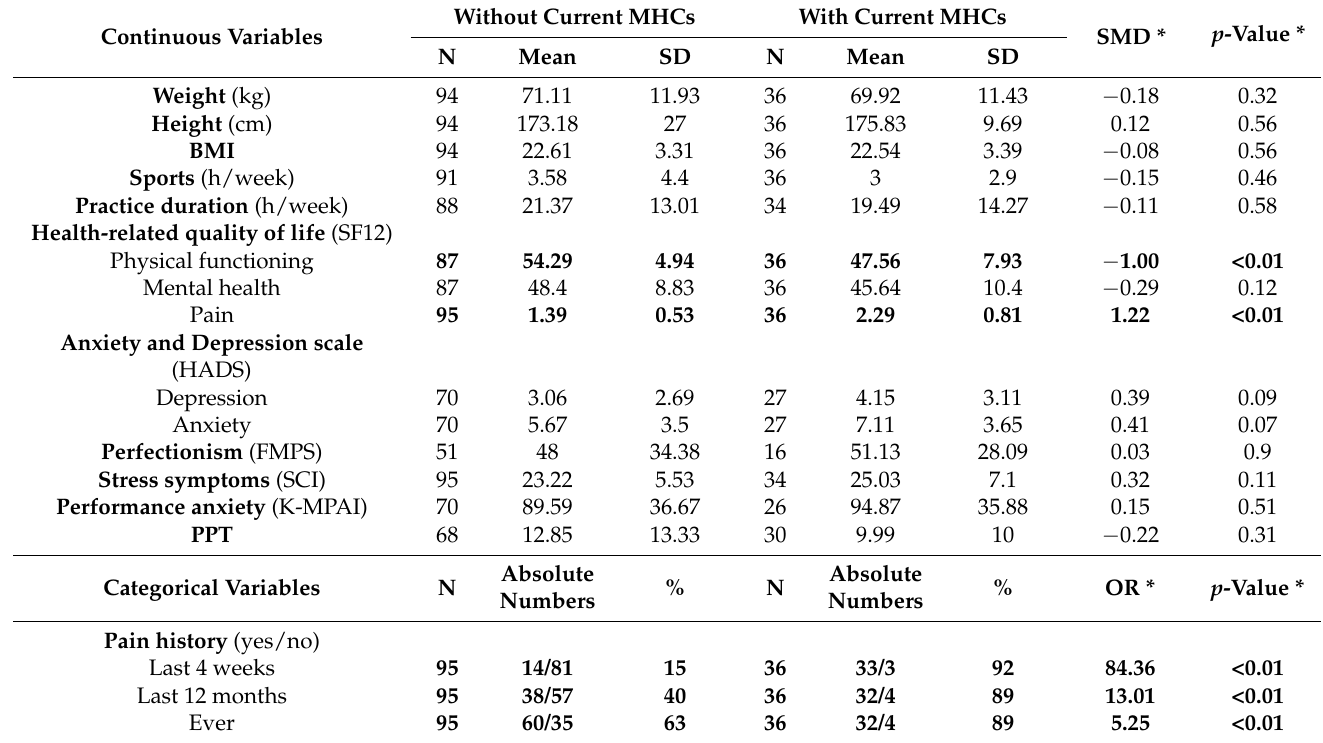
Table 2. Differences between music students with MHCs and those without MHCs (cross-sectional analysis at baseline) represented by standardized mean differences (SMDs) and odds ratios (ORs), respectively, depending on data type (continuous vs.